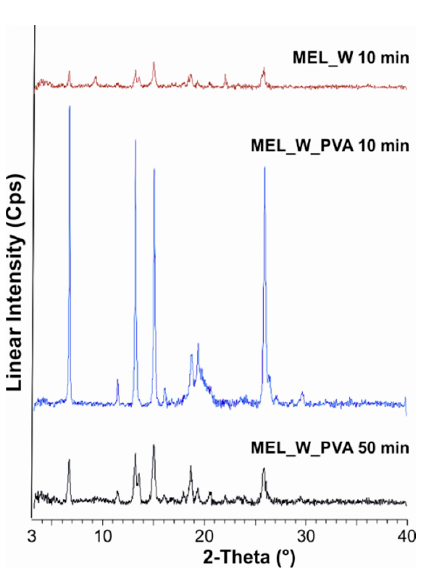
Figure 2. XRPD examination of MEL_W 10 min, MEL_W_PVA 10 min and MEL_W_PVA 50 min.